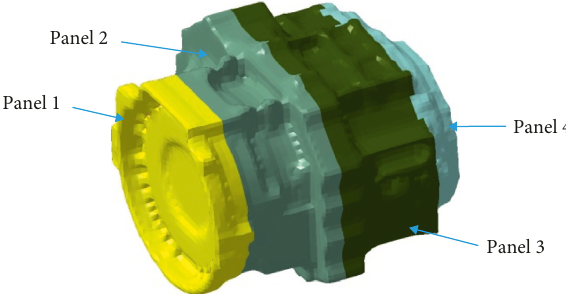
Figure 11: Panel division of the housing.